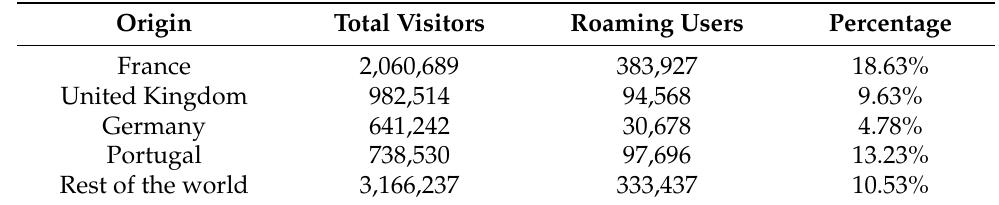
Table 2. Percentage of foreign tourists and visitors by nationality in the sample (November 2019). Sources: Orange Spain and National Statistics Institute of